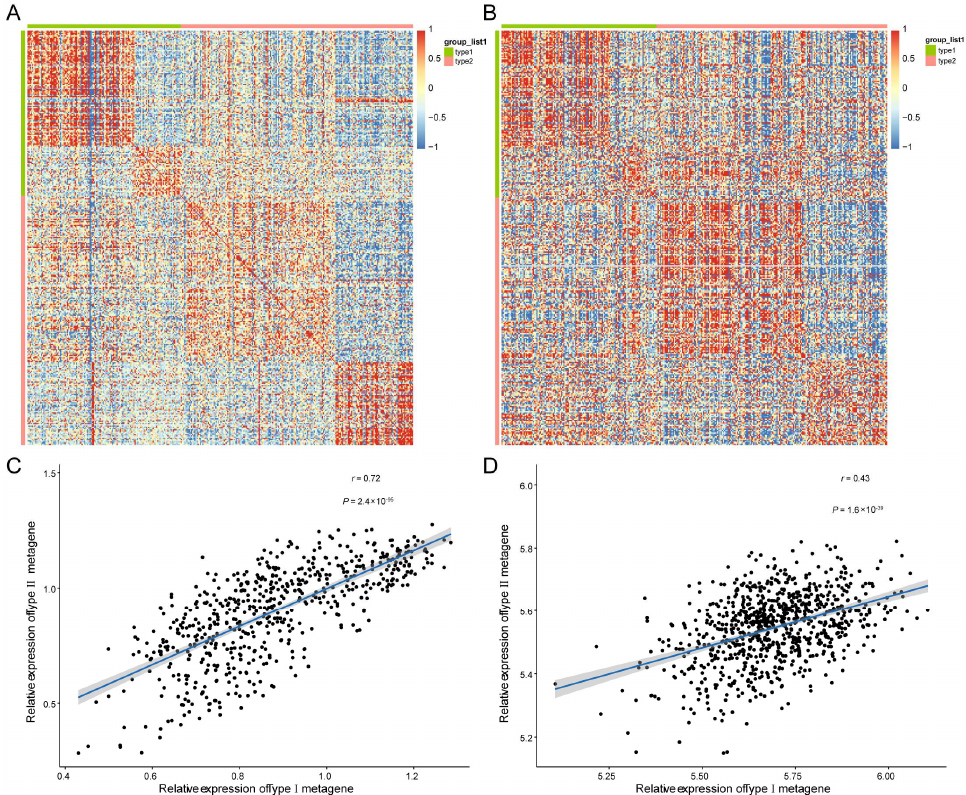
Figure 5. Correlation of bulk and scRNA−seq datasets. ( A ). Heatmap visualization of the DEGs as- sociated with two cell differentiation branches in scRNA−seq datasets. ( B ). Heatmap visualization of the DEGs associated with two cell differentiation branches in TCGA dataset. ( C ). Correlation analysis of metagene scores of Type I and type II marker genes in scRNA−seq dataset. ( D ). Correla- tion analysis of metagene scores of Type I and type II marker genes in scRNA−seq